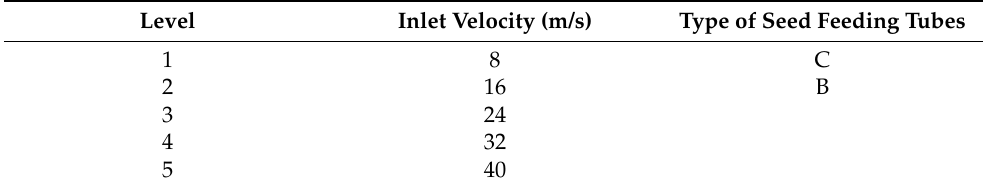
Table 9. The schedule of air CFD experiment for seed